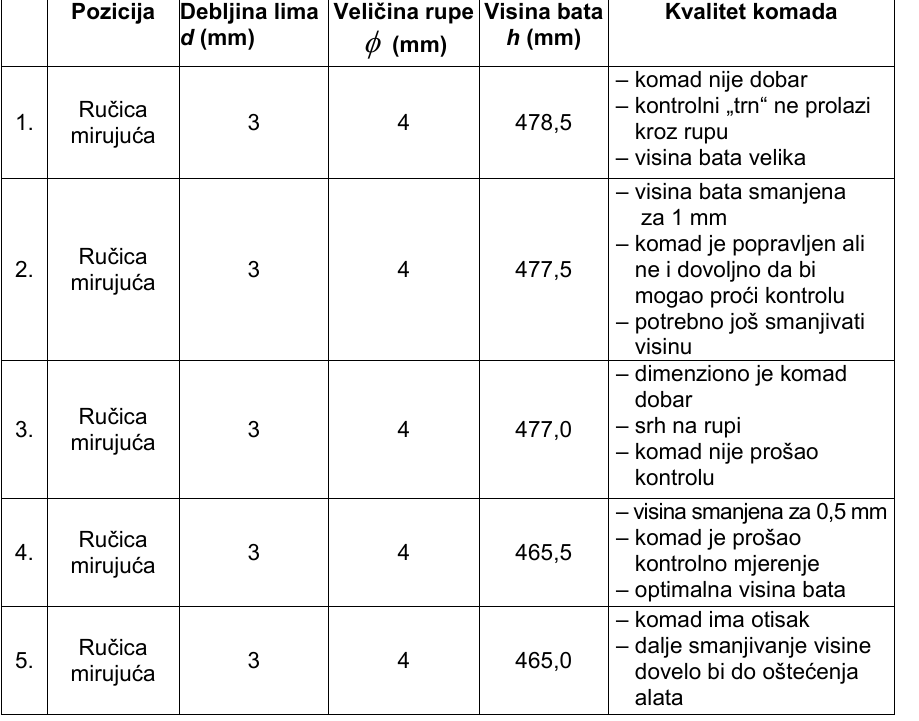
Table 5 – Experimental adjusting of the ram height for the “Ru č ica miruju ć a” position Pozicija Debljina